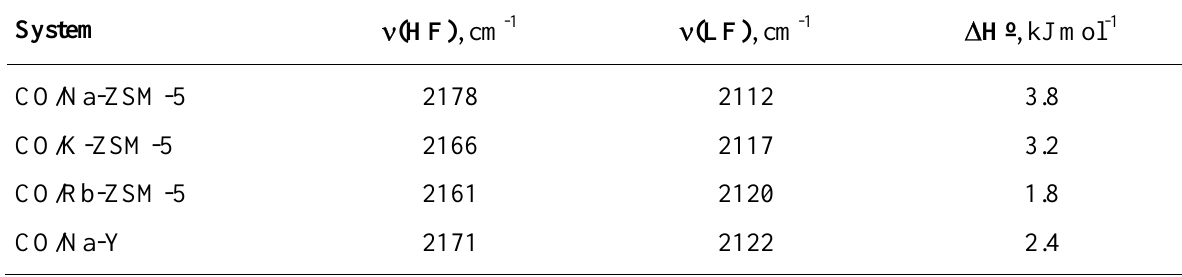
Table 1. Peak position of the HF and LF bands, and ∆ Hº values derived from the corresponding van’t Hoff